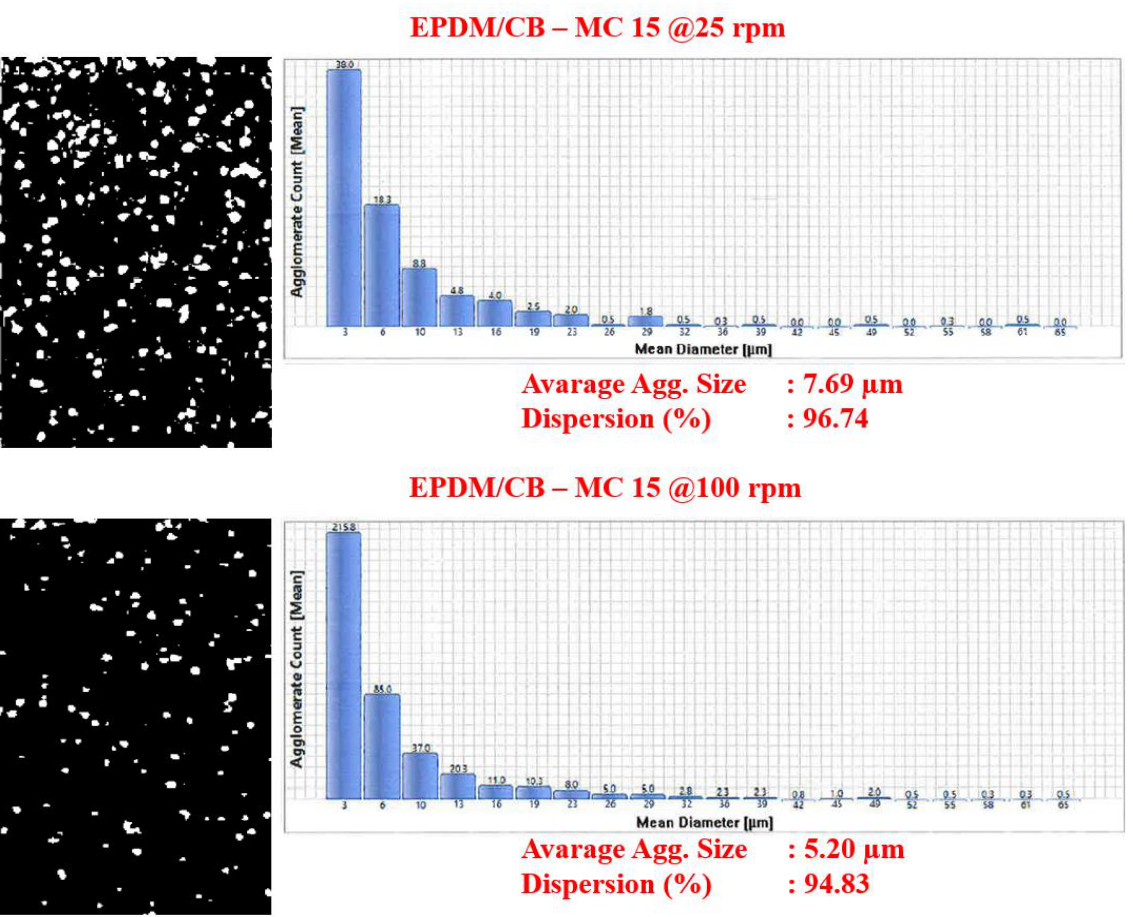
Figure 8. CB dispersion in EPDM composites prepared in MC 15 HT.